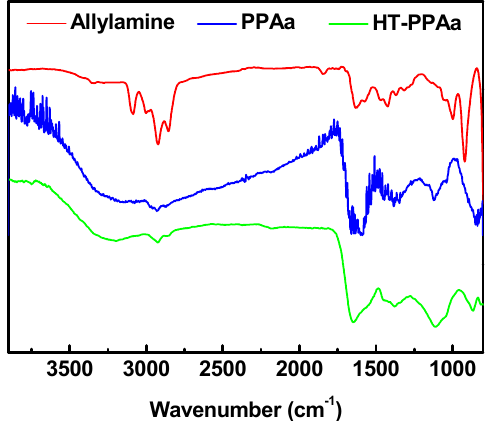
Figure 1. Fourier transform infrared spectrum (FTIR) results of allylamine, plasma polymerized polyallylamine film (PPAa), and annealed polyallylamine film (HT-PPAa) film.